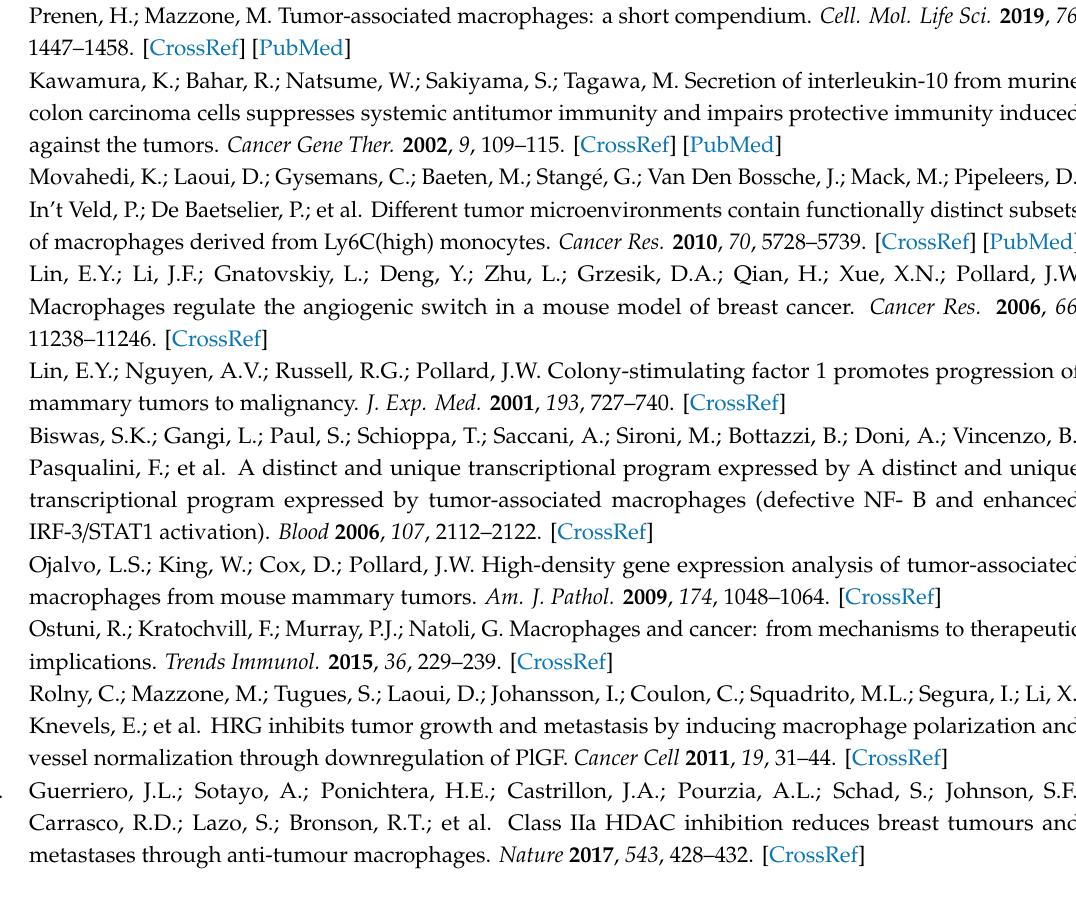
Figure S1 : String analyses associated with sub-network enrichment deduced from shotgun proteomic analyses of NT and PC1 / 3 KD NR8383 macrophages treated or not with 20 ng / mL of IL-10 for 24 h, Figure S2 : String analyses associated with sub-network enrichment deduced from shotgun proteomic analyses of secretome from NT NR8383 macrophages treated with 20 ng / mL of IL-10 for 24 h, Figure S3 : Sub-network analyses of specific proteins identified in ( A ) NT control cells, ( B ) NT cells treated with IL10, ( C ) PC1 / 3 KD control cells, ( D ) PC1 / 3 KD cells treated with IL10, Figure S4 : The string protein analysis revealed interactions of the proteins identified in Cluster 1 after shot gun proteomic studies of NT cells treated with IL-10, Figure S5 : The string protein analysis revealed interactions of the proteins identified in Cluster 2 after shot gun proteomic studies of PC1 / 3 KD cells treated with